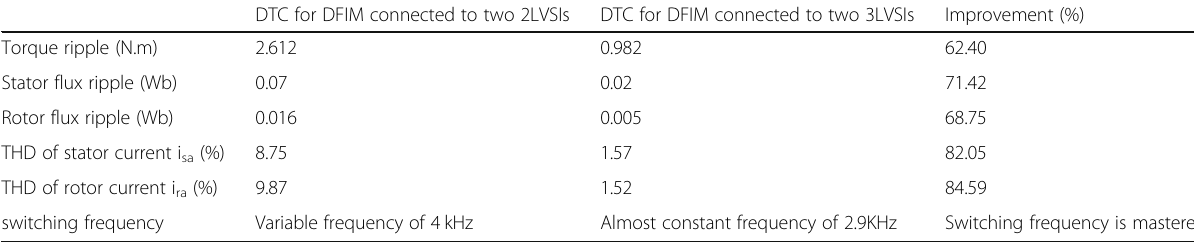
Table 5 Comparison between our proposal and DTC using 2LVSIs DTC for DFIM connected to two 2LVSIs DTC for DFIM connected to two 3LVSIs Torque ripple